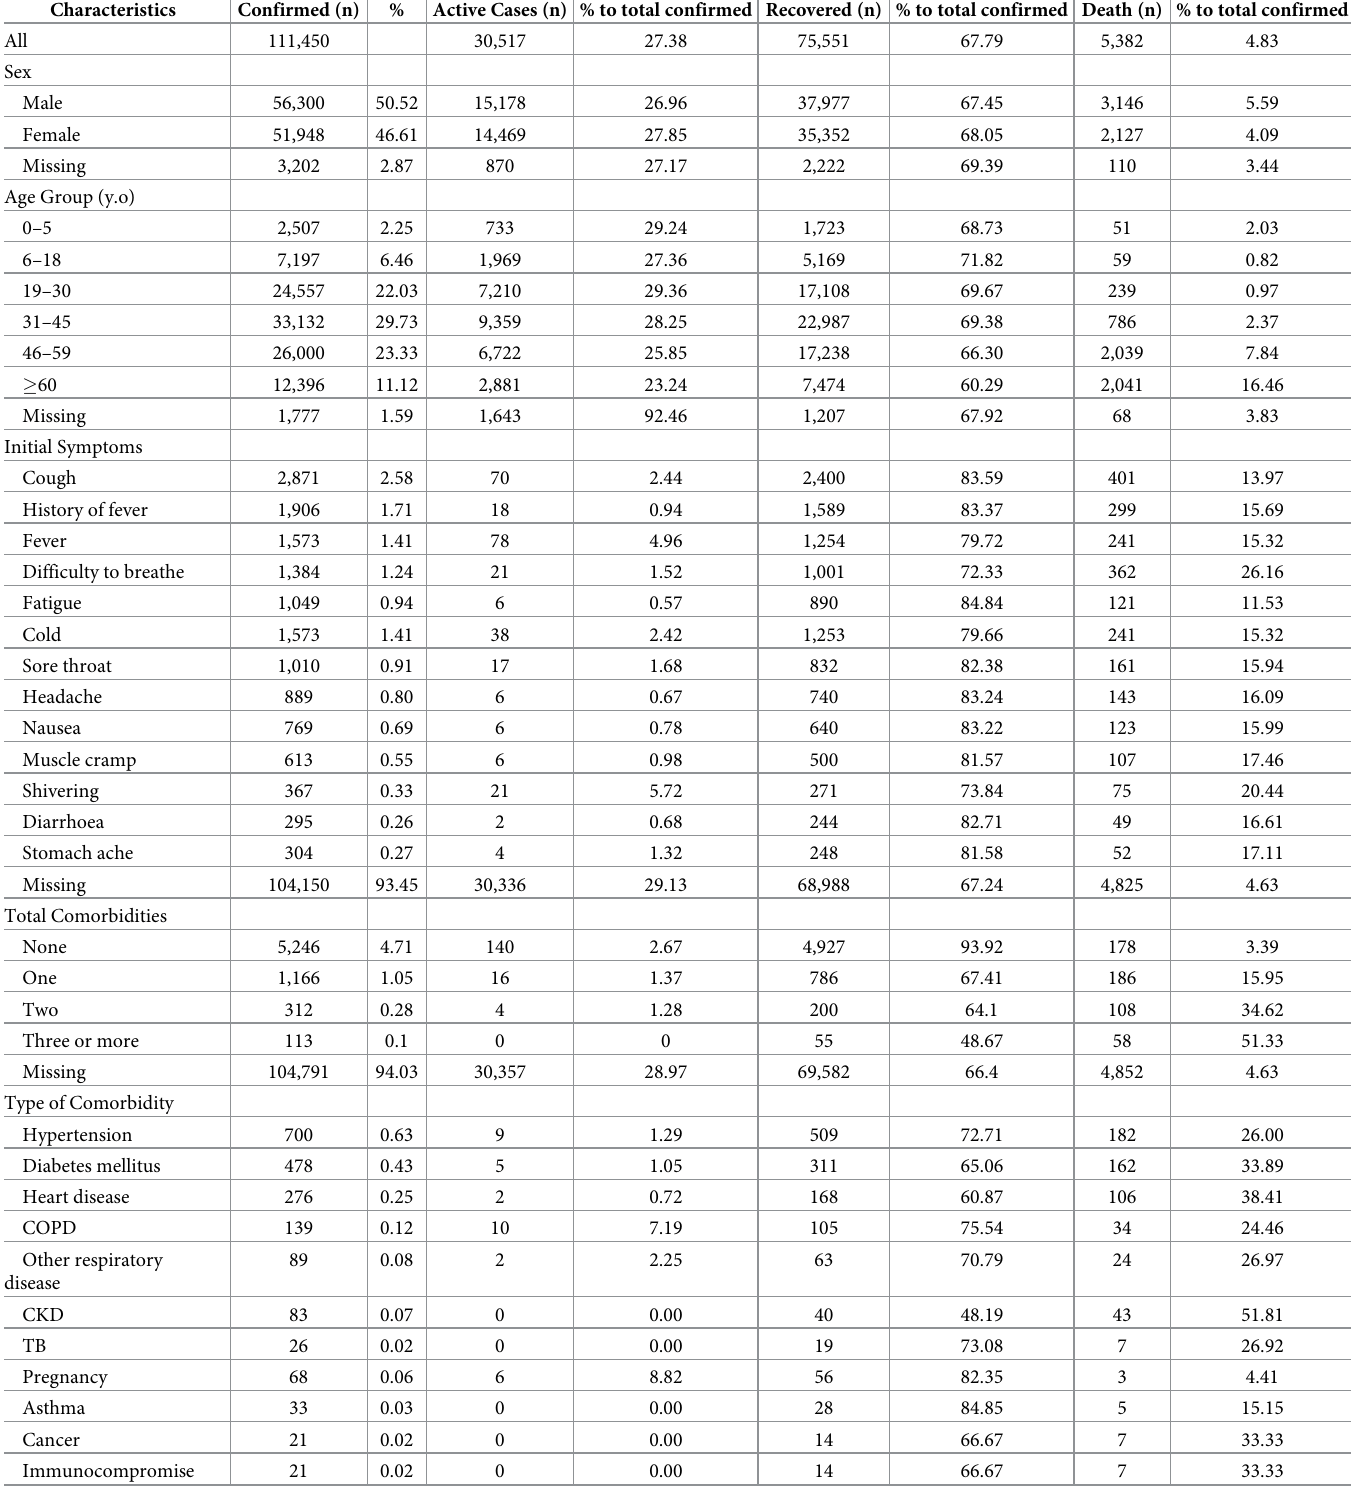
Table 1. Characteristics of total national demographics, symptoms and comorbidity based on case categorization (confirmed, recovered, death) in Indonesia from March 2 nd –August 2 nd 2020.